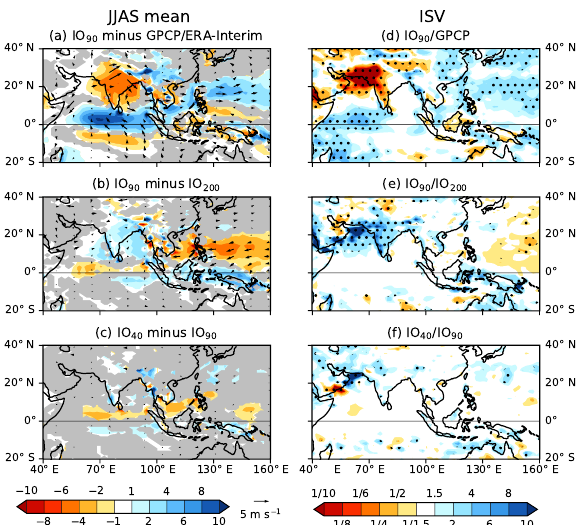
Figure 13. (a–c) JJAS mean precipitation (shading; mmday − 1 ) and 850hPa wind (vectors; ms − 1 ; values below 1ms − 1 not shown): (a) IO 90 minus GPCP–ERA-Interim, (b) IO 90 minus IO 200 , (c) IO 40 minus IO 90 . Grey shading indicates that precipi- tation is statistically insignificant at the 99% level according to a two-tailed t test; vectors (black) are shown only if statistically sig- nificant at the 99% level according to a two-tailed t test. (d–f) Ratio of MJJASO variance of 24–70-day bandpass-filtered precipitation in (mmday − 1 ) 2 : (d) IO 90 over GPCP observations, (e) IO 90 over IO 200 , (f) IO 40 over IO 90 . Stippling indicates 99% statistical sig- nificance according to a two-tailed t test.